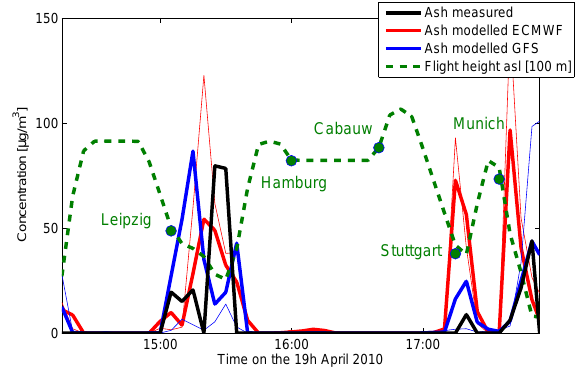
Fig. 10. Same as Fig. 8, but for a research flight over the North Sea and Germany on 18 May